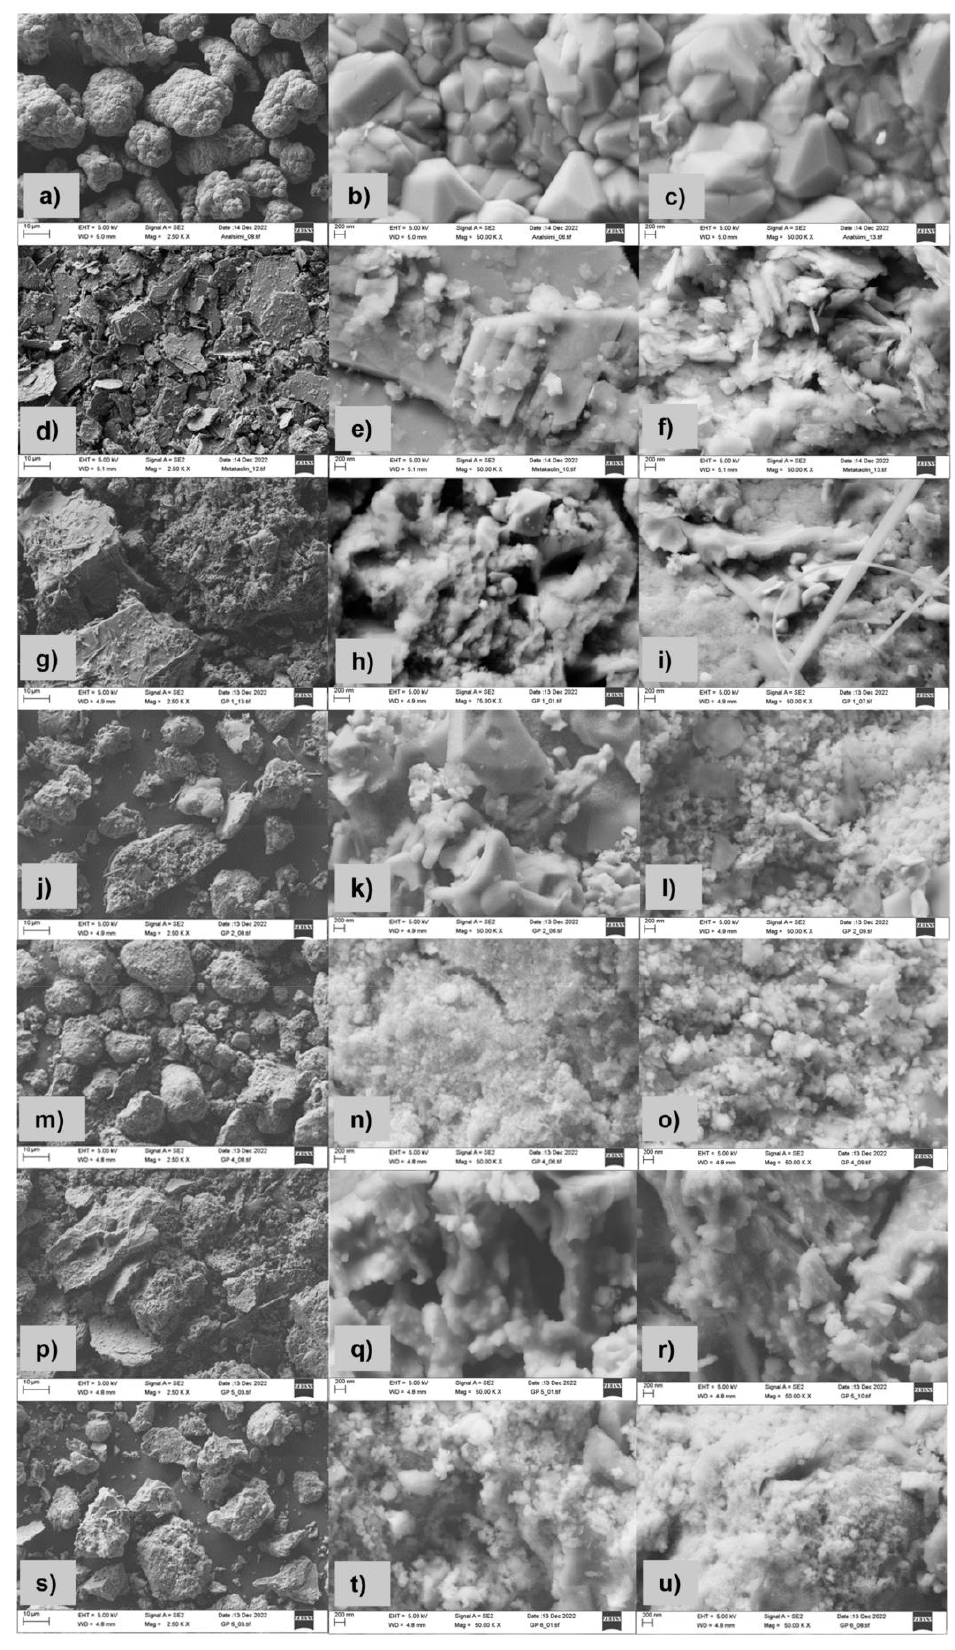
Figure 5. FESEM images of the analcime ( a – c ), metakaolin ( d – f ), ANA-MK 1 ( g – i ), ANA 2 ( j – l ), ANA 3 ( m – o ), ANA-MK 4 ( p – r ) and ANA-MK 5 ( s – u ).